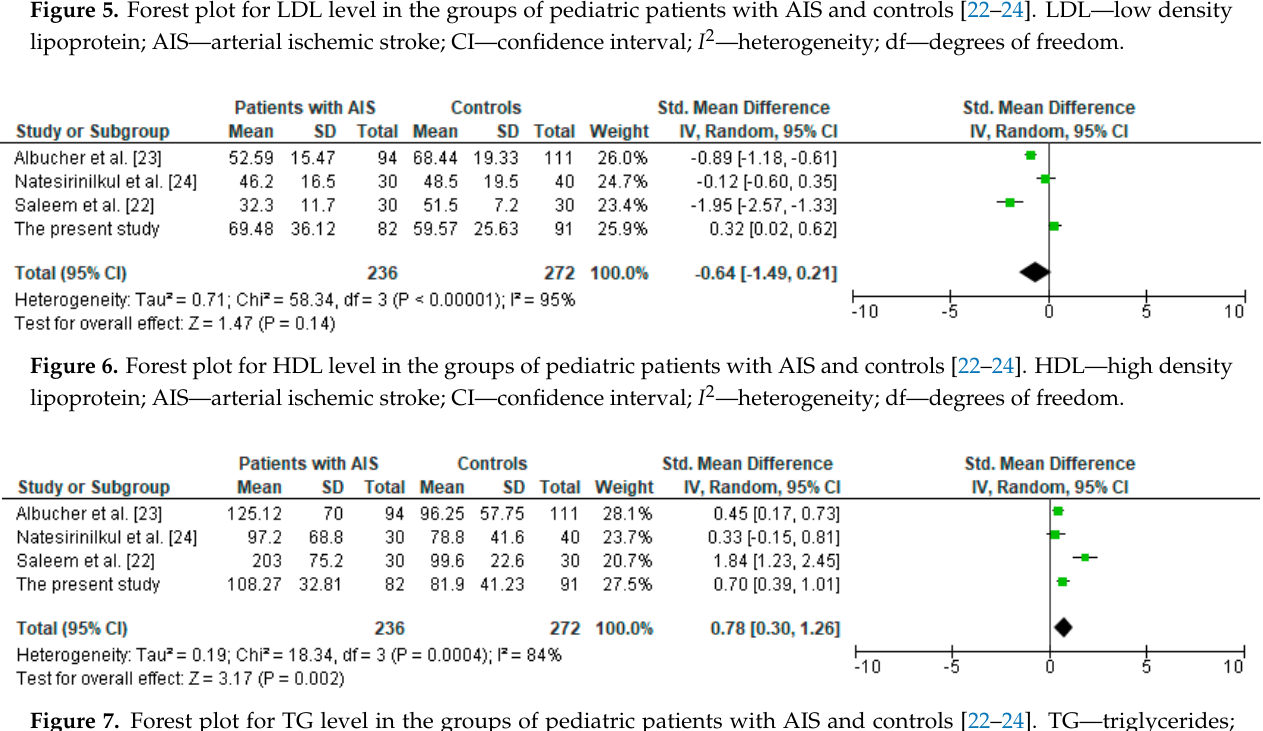
Figure 7. Forest plot for TG level in the groups of pediatric patients with AIS and controls [22–24]. TG—triglycerides; AIS—arterial ischemic stroke; CI—confidence interval; I 2 —heterogeneity; df—degrees of freedom.